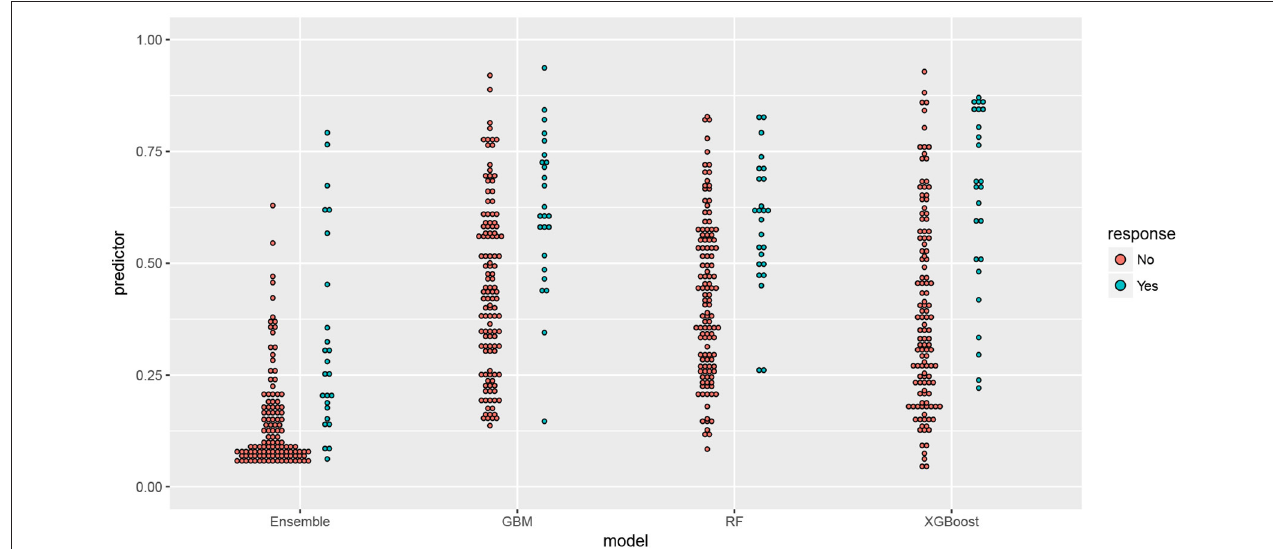
FIGURE 4 | Comparison of predictor and response in the test set for predictive models seen in the article. Along the x-axis are the name of the model split into two groups: positive in MCI and negative in MCI according to the score in the test, on the y-axis is the probability (predictor) assigned by the model.